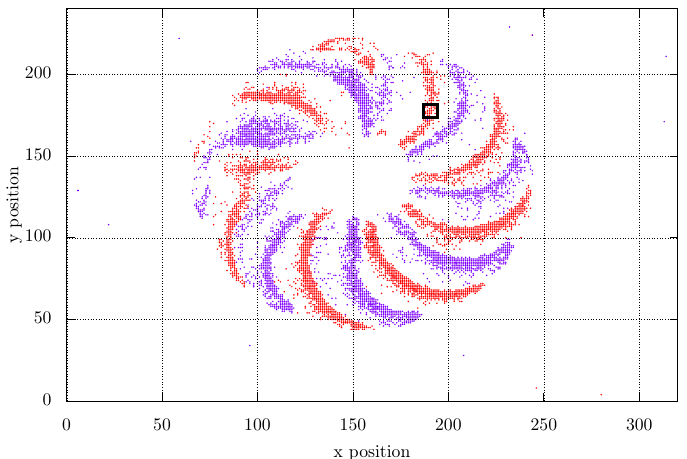
Figure 5. Stream data at 1 ms projected in the same plane and the Kernel is the small